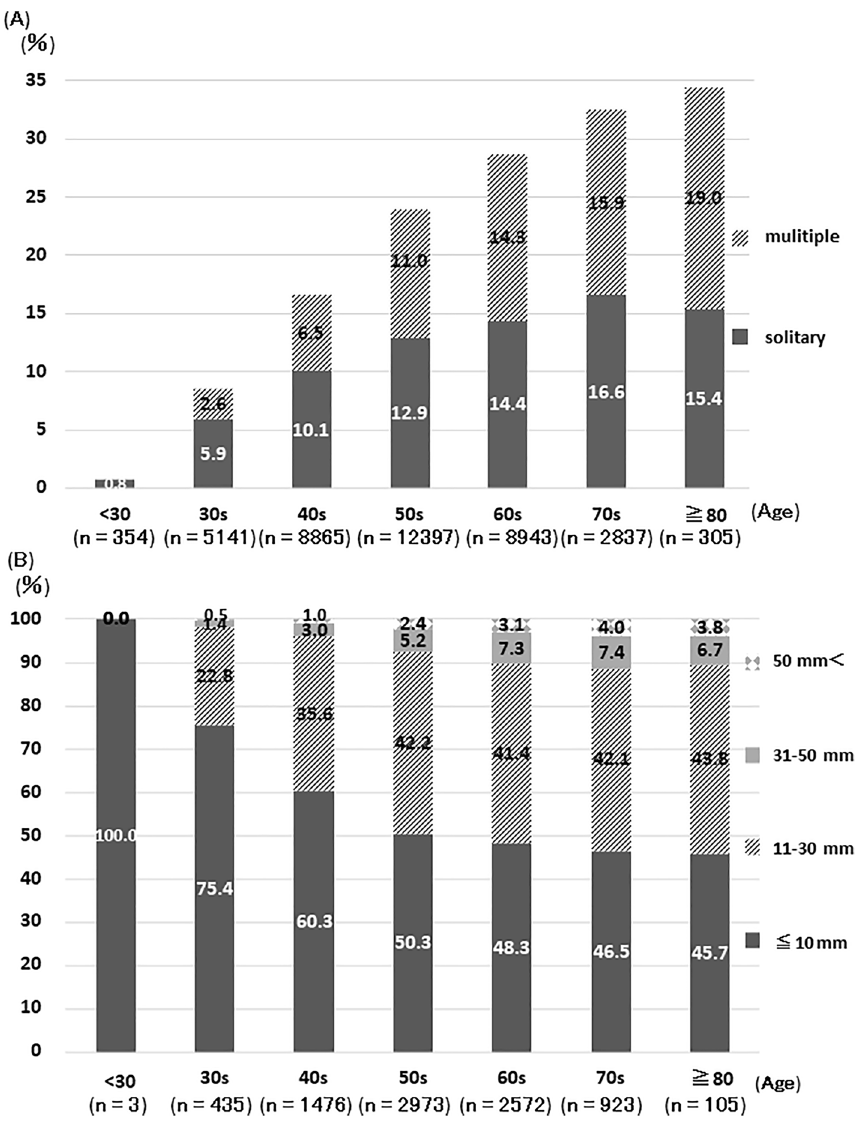
Figure 1. ( A ) Prevalence of hepatic cysts at first health checkup by age group. Multiple cysts was defined as two or more hepatic cysts. ( B ) The maximum hepatic cyst size and age